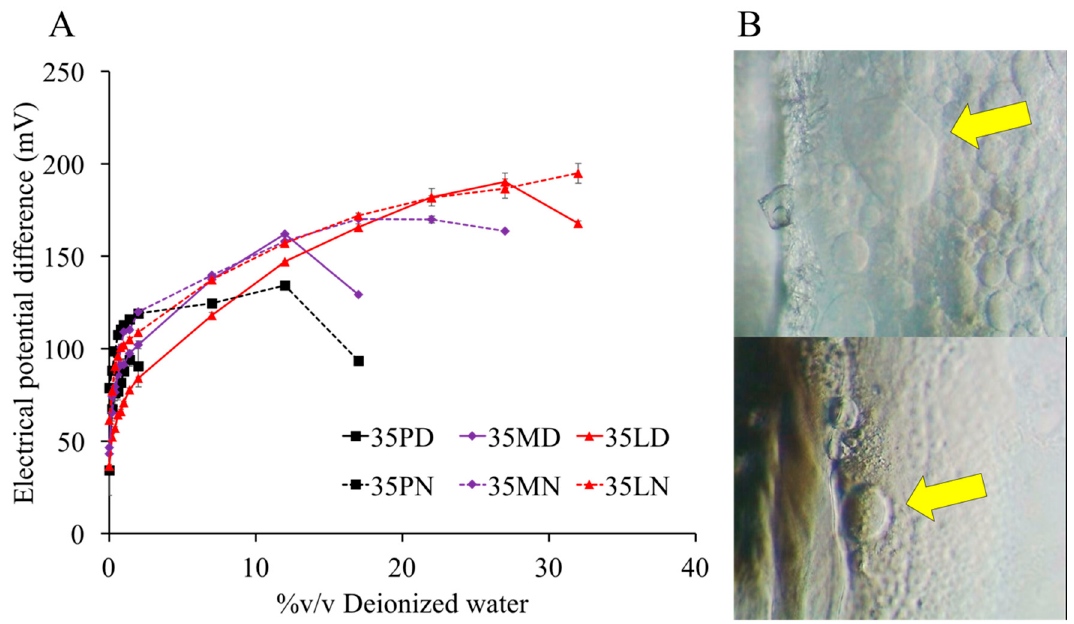
Figure 4. Electrical potential difference of systems (preparation and water) during in situ formation process ( A ) (triplicate testing; n = 3). The appearance of dense liquid at 45th s of 35LD (top) and 35LN (beneath) ( B ) at 400x magnification under inverted microscope.